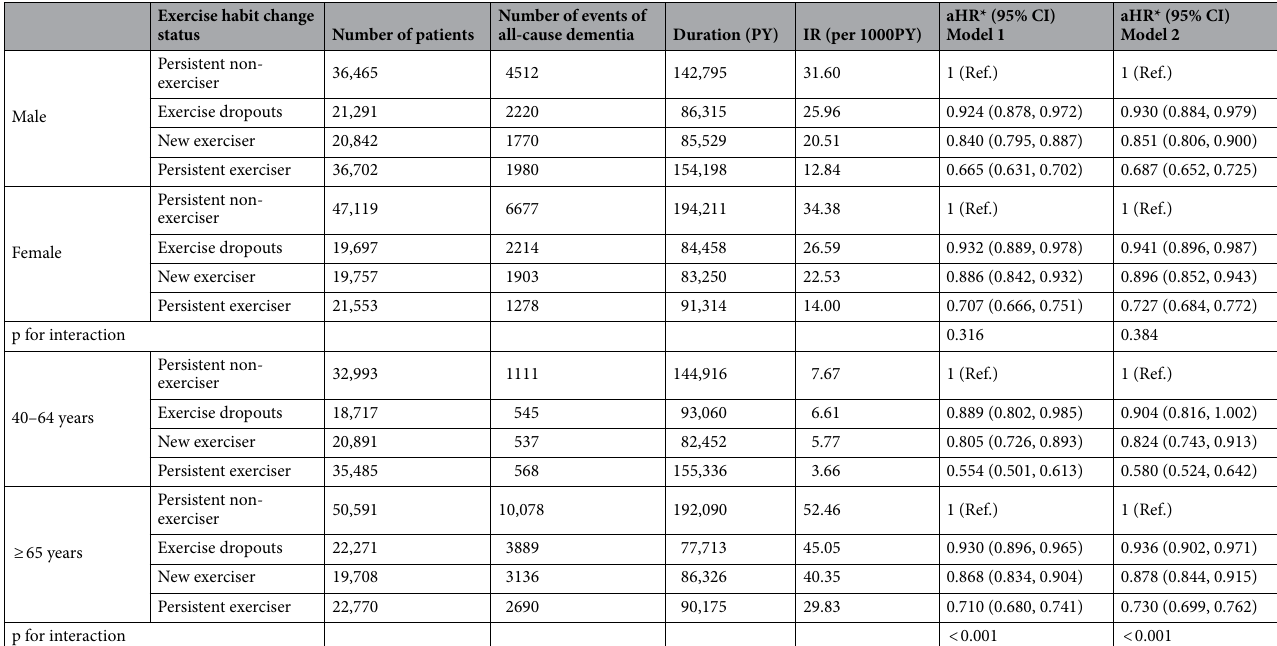
Table 3. Subgroup analyses according to the age and sex group and risk for all-cause dementia. IR, Incidence rate; aHR, adjusted hazard ratio; PY, person-years. # Model 1: age and sex adjusted, Model 2: Model 1 + smoking status, alcohol status, low income, history of diabetes, hypertension, dyslipidemia and chronic kidney disease